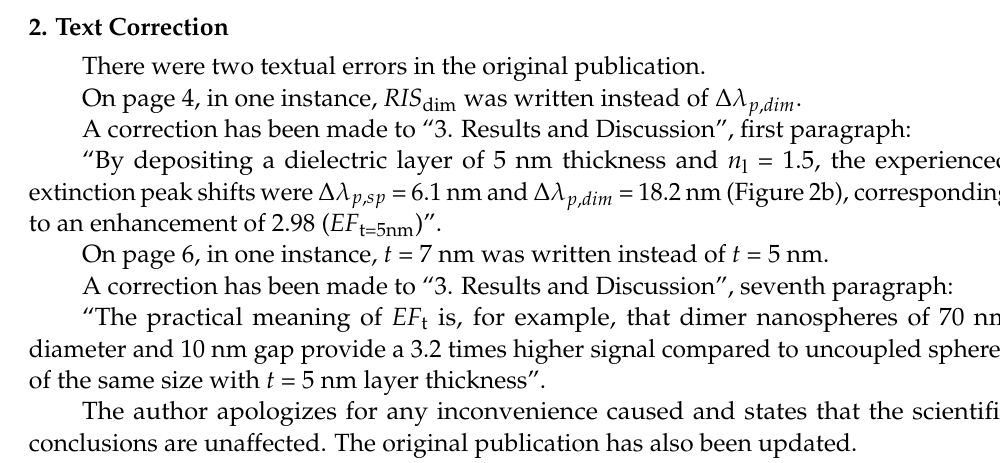
Figure 6. ( a ) Extinction peak shift ( ∆ λ p ) of different dimer arrangements as a function of the dimensionless D / D 0 value ( D 0 = 70 nm) with a dielectric layer of 5 nm ( n l = 1.5 in water medium, with n = 1.33). ( b ) Relative extinction peak shift as a function of the dimensionless D / D 0 value, where ∆ λ p − max is calculated as the peak shift upon the RI of the medium changing from 1.33 to 1.5. ( c ) Enhancement factor ( EF t=5nm ) as a function of D / D 0 . ( d ) Difference between surface and bulk enhancement factors ( EF t=5nm -EF ∞ ) as a function of D / D 0 .